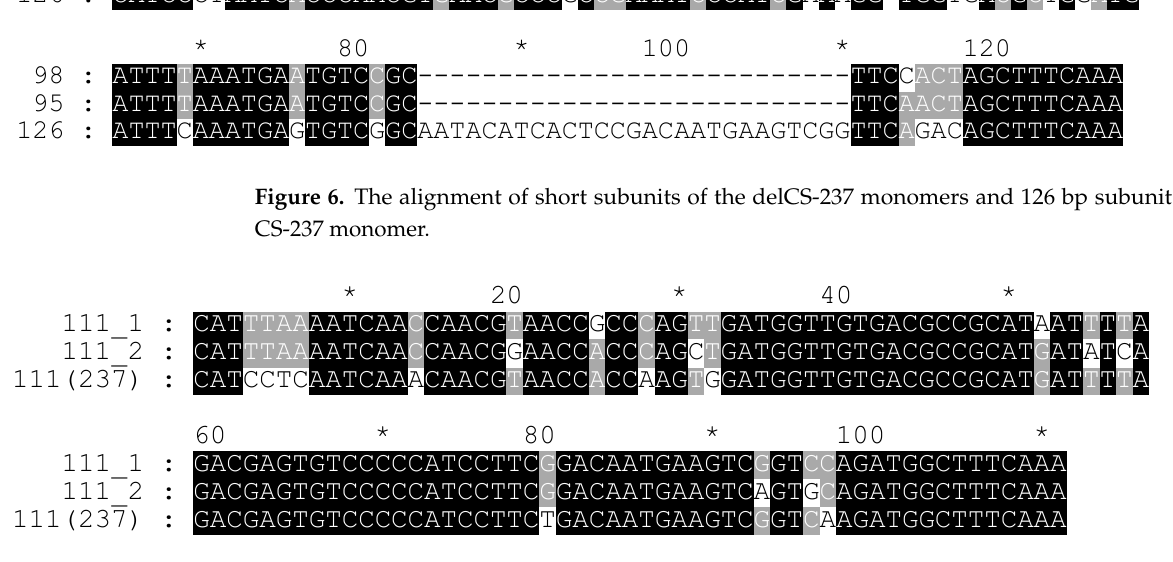
Figure 7. The alignment of long subunits of the delCS ‐ 237 monomers and 111 bp subunit of the CS ‐ 237 monomer.